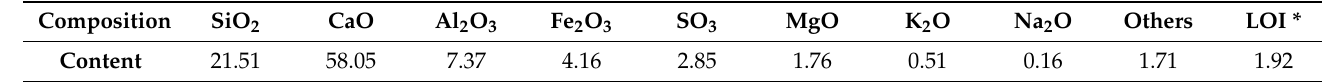
Table 1. Chemical compositions of P.O. 42.5 ordinary Portland cement (wt. %).